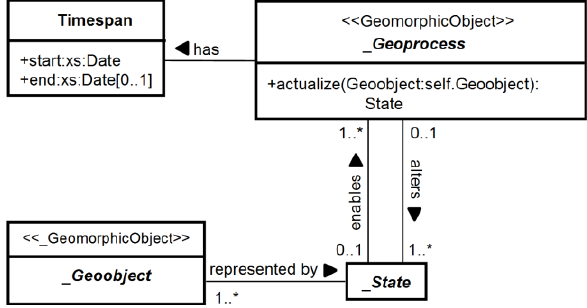
Figure 2. The abstract class _Geoprocess , altering, i.e. creating a new instance of the class _State . (Löwner, 2010,